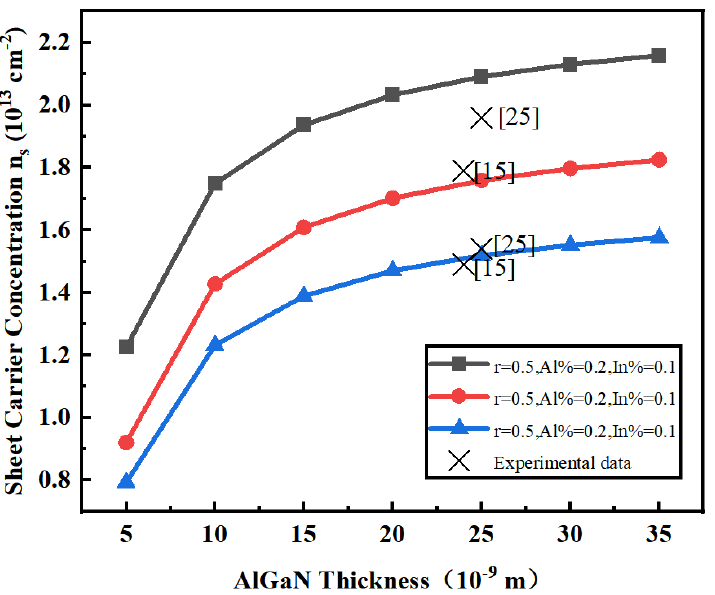
Figure 6. Comparison of model calculation results by (8), and experimental data. Compare the 2DEG density calculated according to the different degrees of strain relaxation with experimental data.